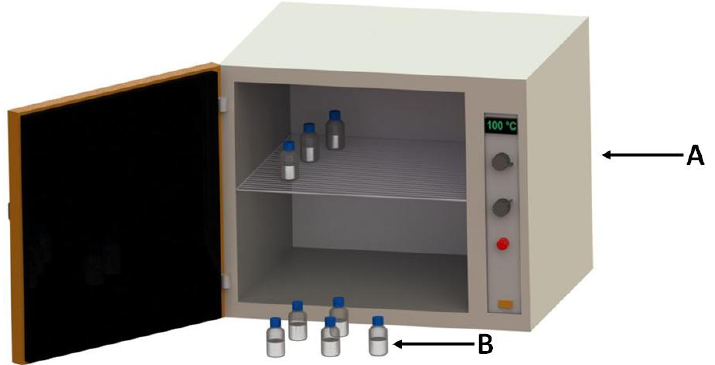
Figure 7. Experimental setup illustrating the hydrothermal treatment step whereby zeolite A crystals are formed. (A) Hot air oven; (B) 250 mL glass bottles containing adjusted clear solution ready for hydrothermal